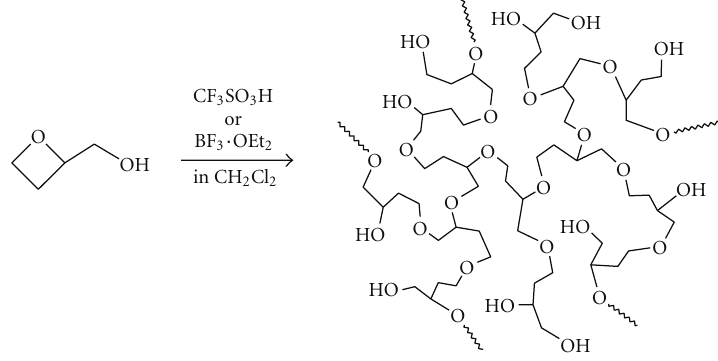
Scheme 5: Synthesis of hyperbranched poly(2-hydroxymethyloxetane).